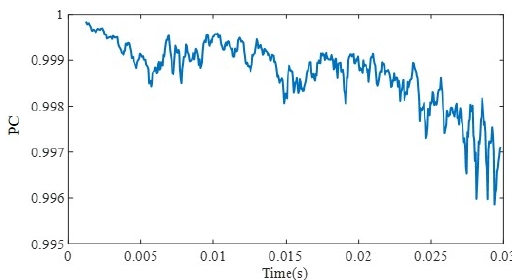
Figure 7. Peak coherence of example signal.